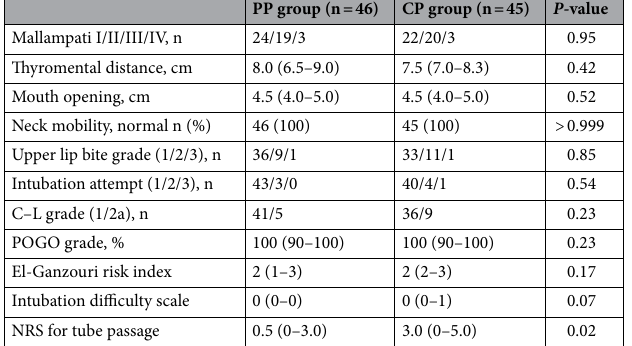
Table 2. Characteristics related to airway and tracheal intubation. C–L Cormack–Lehane, POGO percentage of glottis opening, NRS numeric rating scale. Continuous variables are presented as median (25th to 75th quartile). Nominal variables are presented number or number (frequency).